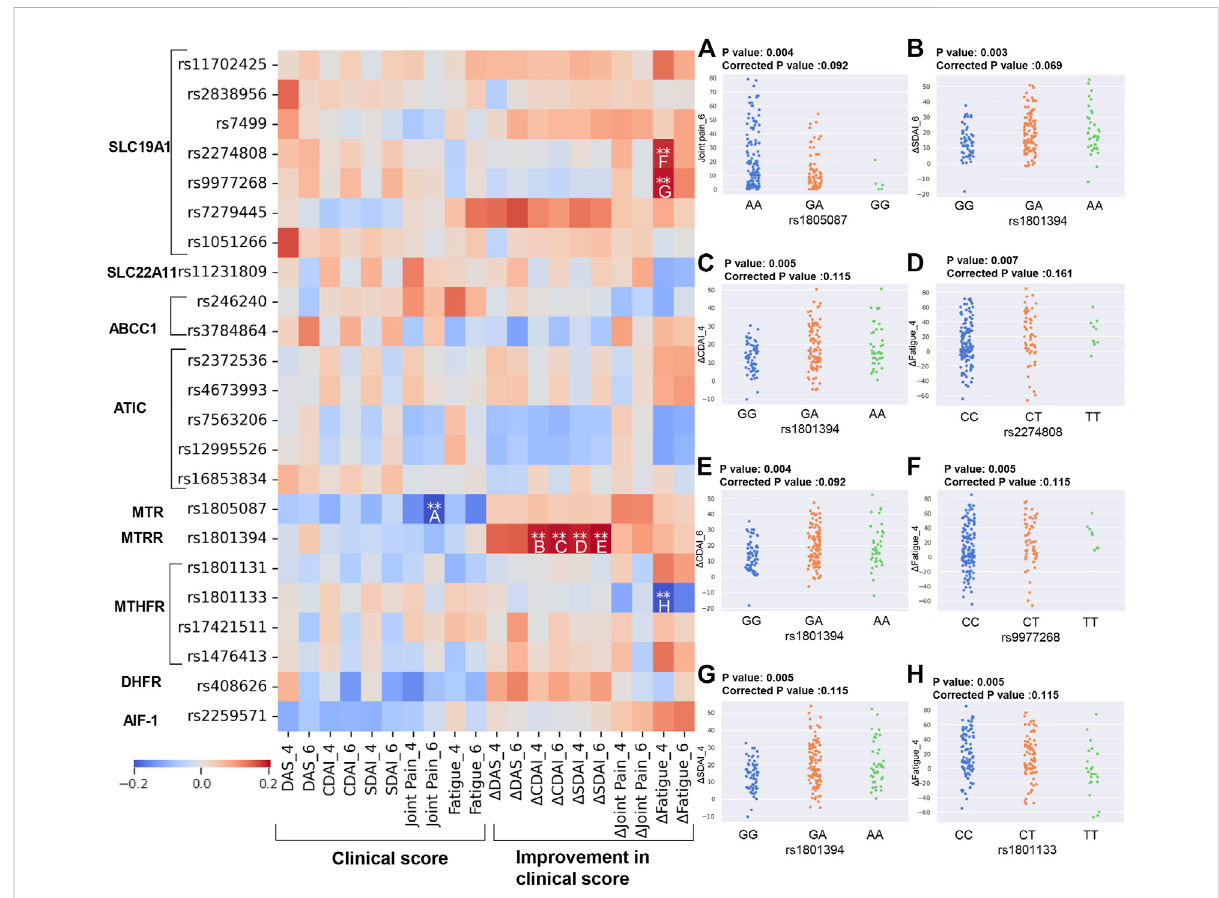
FIGURE 4 Identi fi cation of SNPs correlated to different continuous clinical outcomes. Heatmap showing the correlation between SNPs involved in MTX metabolism and continuous clinicaloutcomes bySpearman ’ s rank correlation test. The correlation with signi fi cant p -value (calculated by Spearman rank **raw p -value ≤ 0.01) and relatively high coef fi cient (absolute value of correlation coef fi cient > 0.18) were marked by asterisk. These signi fi cant associations were further shown by scatter plots (A – H) , including rs1805087 and joint pain_6 (A) , rs1801394 and Δ CDAI_4 (B) , rs1801394 and Δ CDAI_6 (C) , rs1801394and Δ SDAI_4 (D) ,rs1801394and Δ SDAI_6 (E) ,rs2274808and Δ Fatigue_4 (F) , rs9977268 and Δ Fatigue_4 (G) , rs1801133 and Δ Fatigue_4 (H) . The Bonferroni corrected p -value was estimated based on hypotheses tested on 23 SNPs to adjust signi fi cant results for multiple testing. The raw p -values (without Bonferroni correction adjustment) were also reported becauseof the exploratory nature of the analyses and tobetterhighlightnuancesintheresultsthatwouldbelessvisibleaftercorrection.Deltavaluesmeansimprovementsinclinicaloutcomesfrom baseline value(baseline value – current value). DAS, Disease activity score; CDAI, Clinical Disease Activity Index; SDAI, Simpli fi edDisease Activity